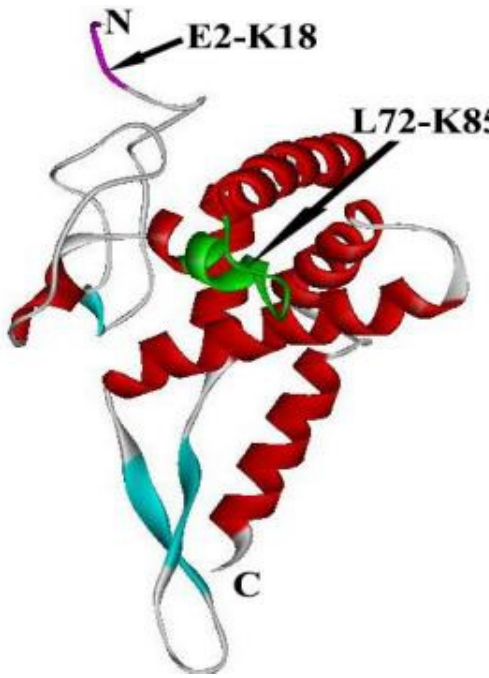
Figure 4. Crystal structure of Homo RPS5 is separated from the structure of Homo 40S using software of chimera. The red fragment is T2-K18, and the green fragment is L72-K85. Regions deleted by mutagenesis are shown in aqua, but residues M1-E13 are absent in this structure.